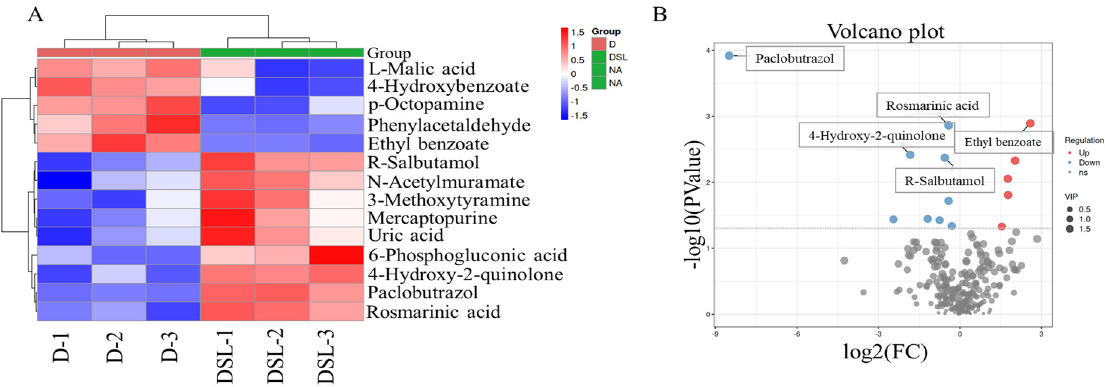
Figure 6. Heat map showing fold changes for metabolites responsive to rac − GR24 treatment, with increases (upregulation showing in red) or decreases (downregulation showing in blue) in the root exudates in drought stress compared to the rac − GR24 treatment ( A ). The volcano maps show significantly upregulated or downregulated metabolites ( B ).